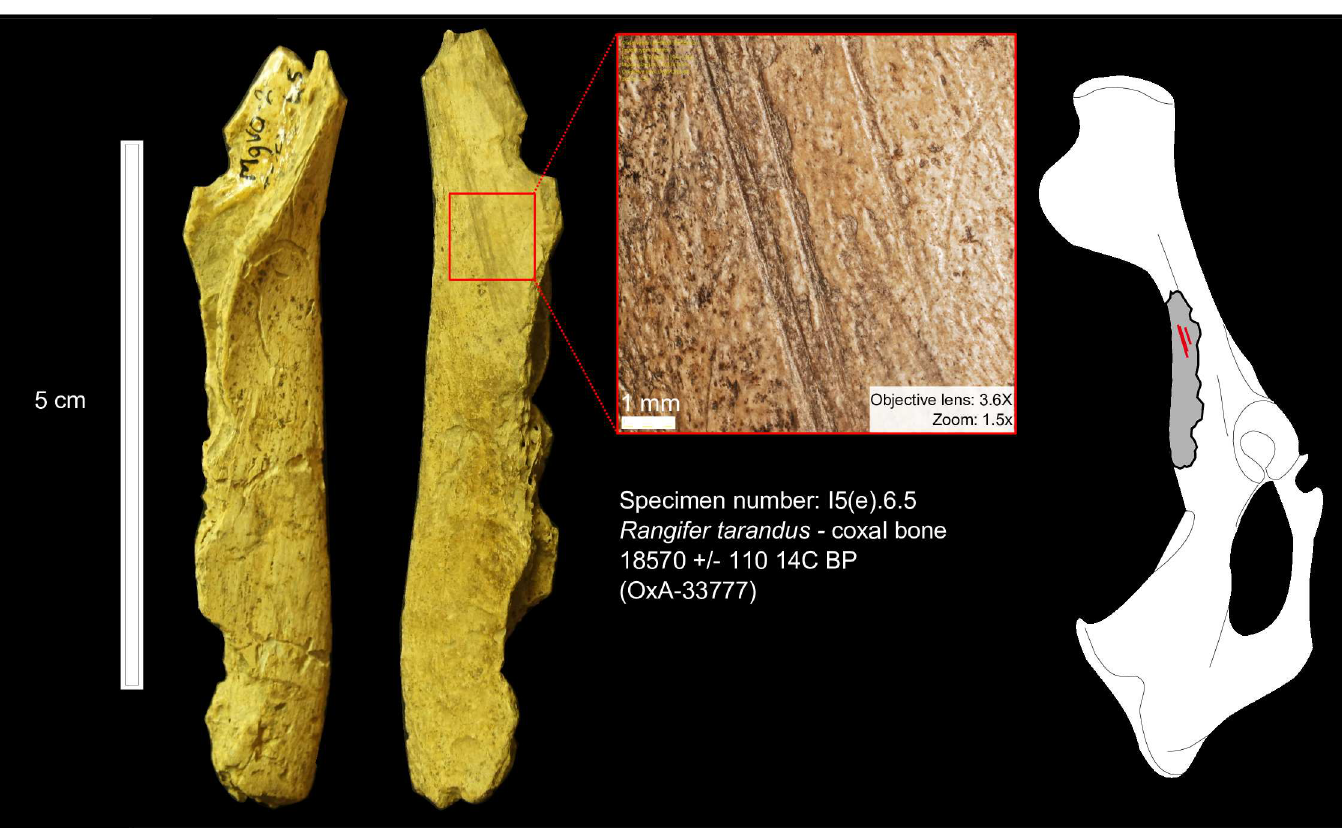
Fig 2. Cut marks on a caribou coxal bone from Cave II. The specimen(# I5.6.5) is dated to 18,570 ± 110 14 C BP (OxA-33777) and shows straight and parallelmarks resultingfrom filleting